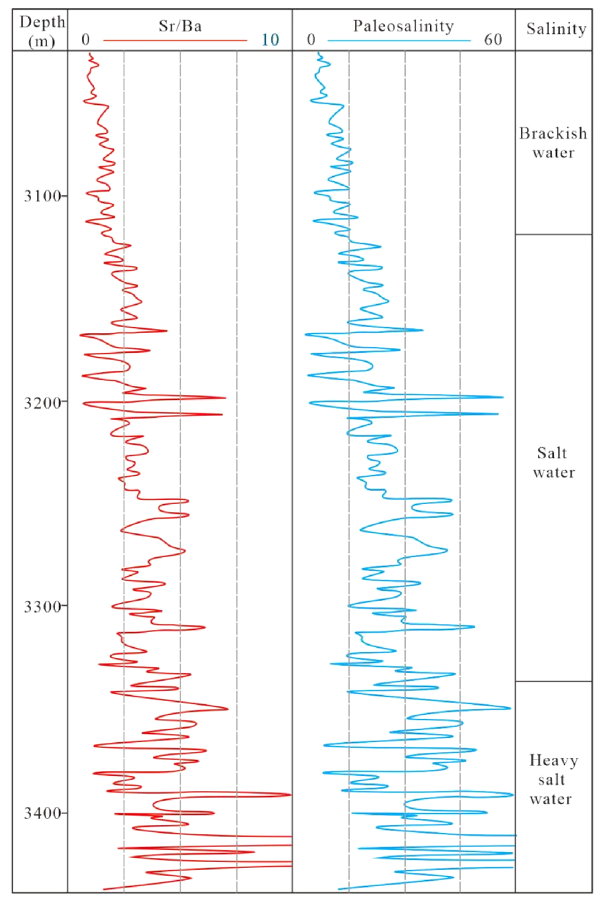
Fig. 2 Vertical variation of paleosalinity in the Dongying